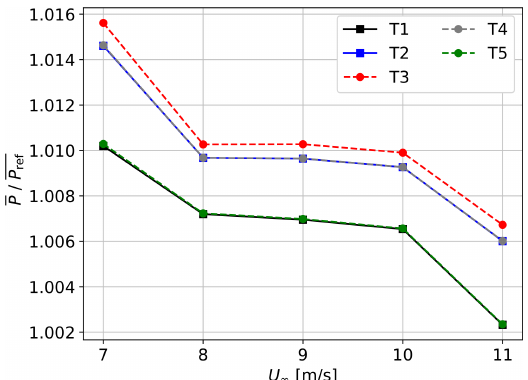
Figure 8. Power output of the five turbines in the row averaged over an inflow sector and normalised by the average power output of the isolated turbine for several values of U ∞ and a normal distribution N θ ( µ θ = 0 ◦ ,σ θ = 41 ◦ ) for θ